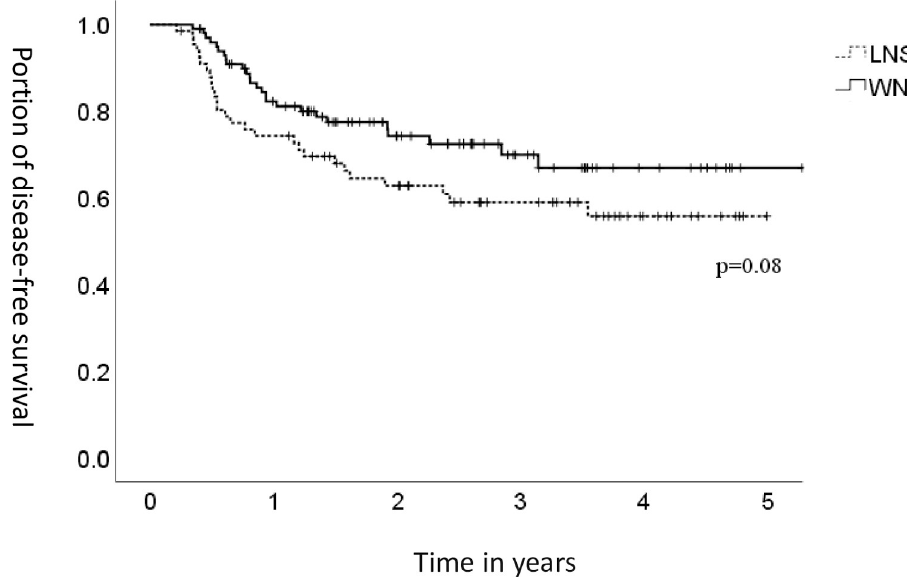
Fig 2. Disease-free survival. WNI, whole-neck irradiation; LNS, lower-neck sparing.